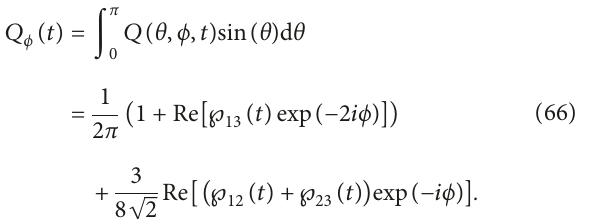
Figure 7: The marginal distribution Q (c) τ �